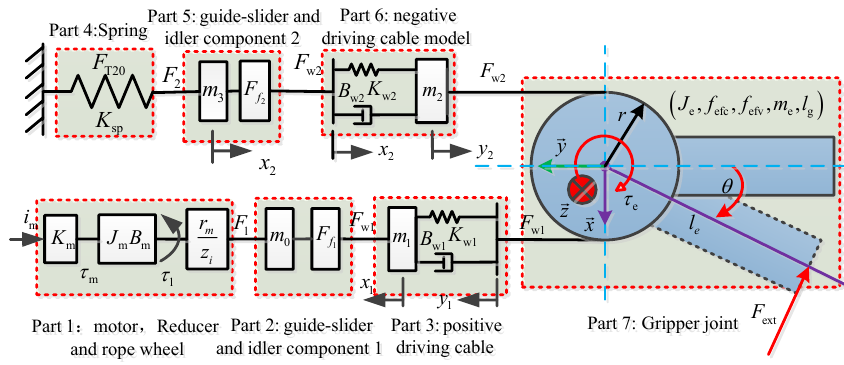
Figure 4. The mechanism model diagram of the single joint principle prototype.